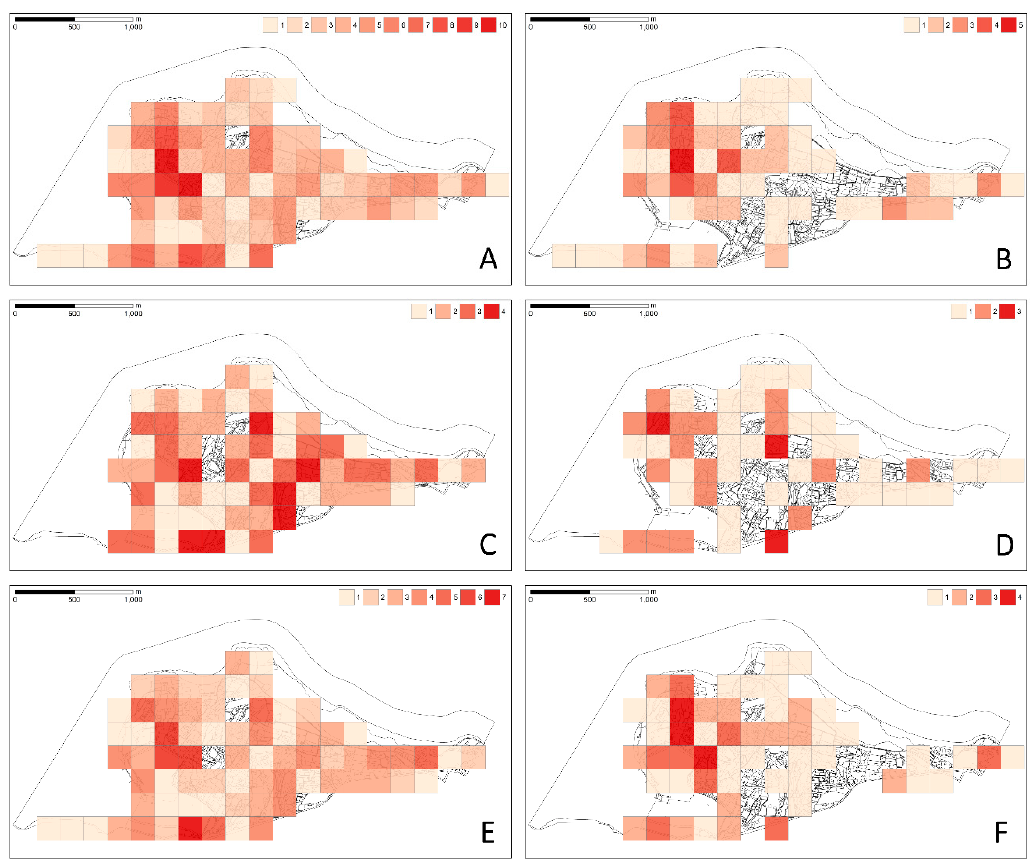
Figure 3. Diversity of aliens in the study area based on different categories expressed as the richness of ( A )—all taxa; ( B )—woody perennials and vines; ( C )—annual herbs; ( D )—invasive species; ( E )—taxa with seed dispersal; ( F )—taxa with vegetative dispersal. Numbers and colors in the legends indicate the number of taxa/species per grid cell.